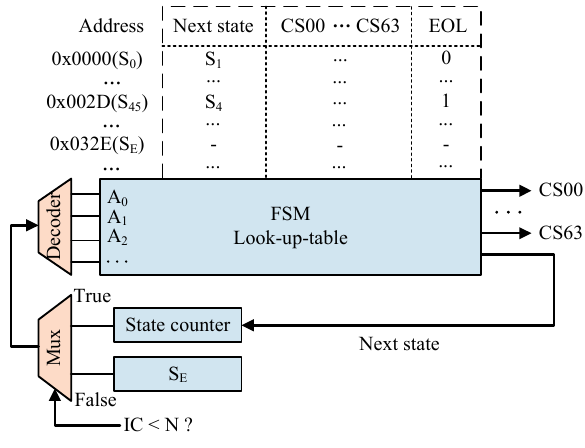
Figure 13: Design of the finite state